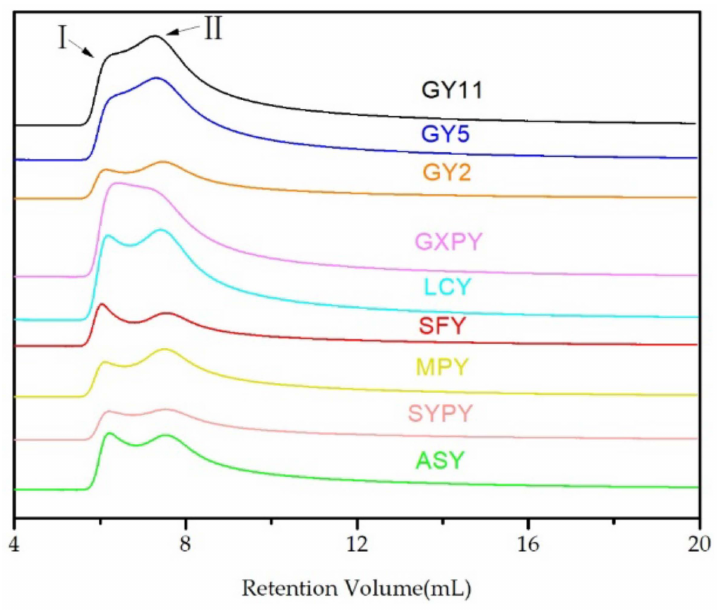
Figure 1. The gel permeation chromatogram of yam starch. Remark: I: Amylopectin elution peak; II: Amylose elution